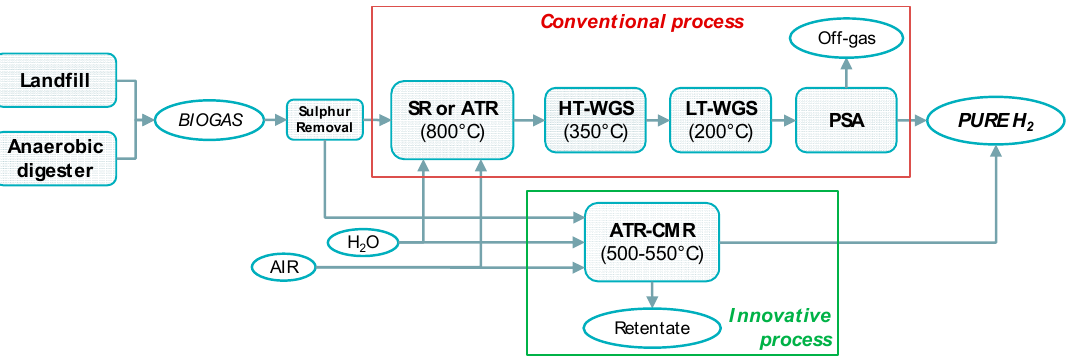
Figure 1. Hydrogen production from biogas.